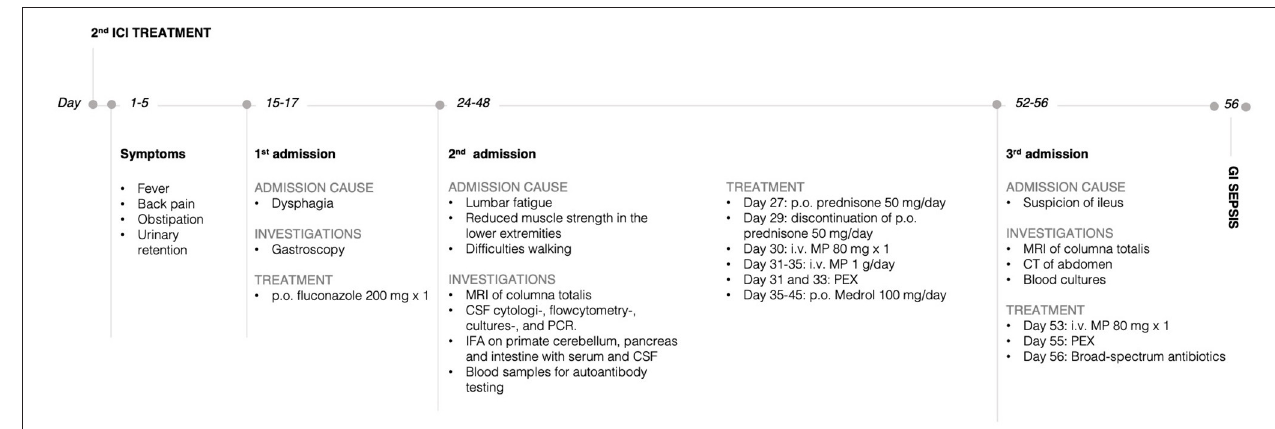
FIGURE 3 | Timeline with selected events and data. p.o., oral; i.v., intravenous; MRI, magnetic resonance imaging; CSF, cerebrospinal fluid; IFA, indirect immunofluorescence assay; MP, methylprednisolone; PEX, plasmapheresis; CT, computer tomography; GI, gastrointestinal.